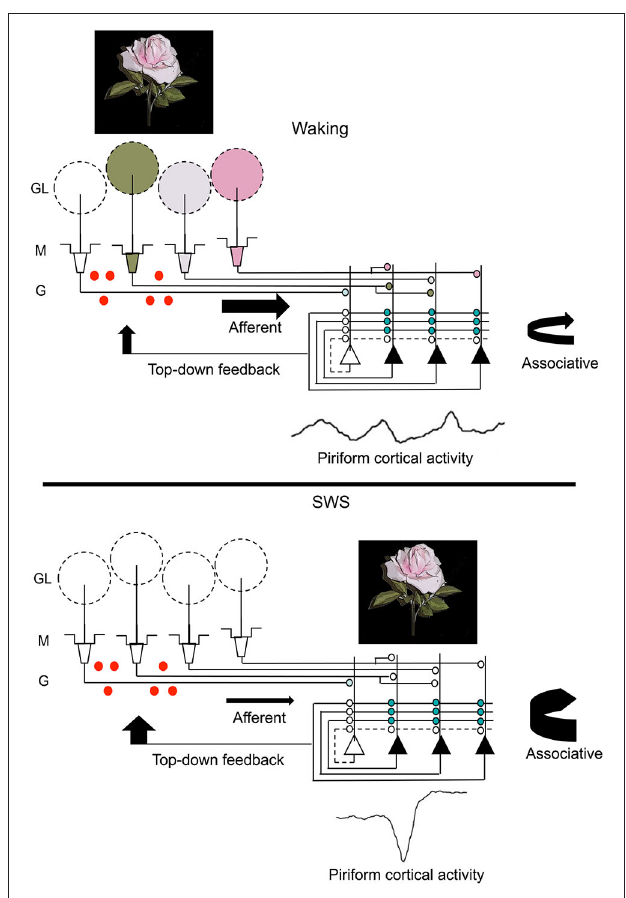
FIGURE 3 | A schematic representation of changes in olfactory system activity between waking and slow-wave sleep . Odor stimulation during waking (symbolized by the rose) evokes odor-specific patterns of activity in the OB and mitral/tufted cell output to the piriform cortex. This afferent activity is respiration entrained and evokes intra-cortical association fiber activity linking co-active piriform cortical neurons. It also results in piriform cortical output, including feedback to OB granule cells (red dots) as well as to other regions of olfactory cortex and non-olfactory regions. During slow-wave sleep, the balance of afferent and intracortical activity shifts, with decreases in sensory-evoked input to piriform cortex and enhanced intra-cortical mediated activity, primarily during sharp-wave events. The sharp-wave associated activity replays cortical ensemble activity evoked by odors during waking. These strong, synchronous sharp-wave events help strengthen synaptic connections within odor-coding ensembles, as well as help shape OB granule cell survival in an odor-specific manner. Abbreviations: GL = glomerular layer, M = mitral cell layer, G = granule cell